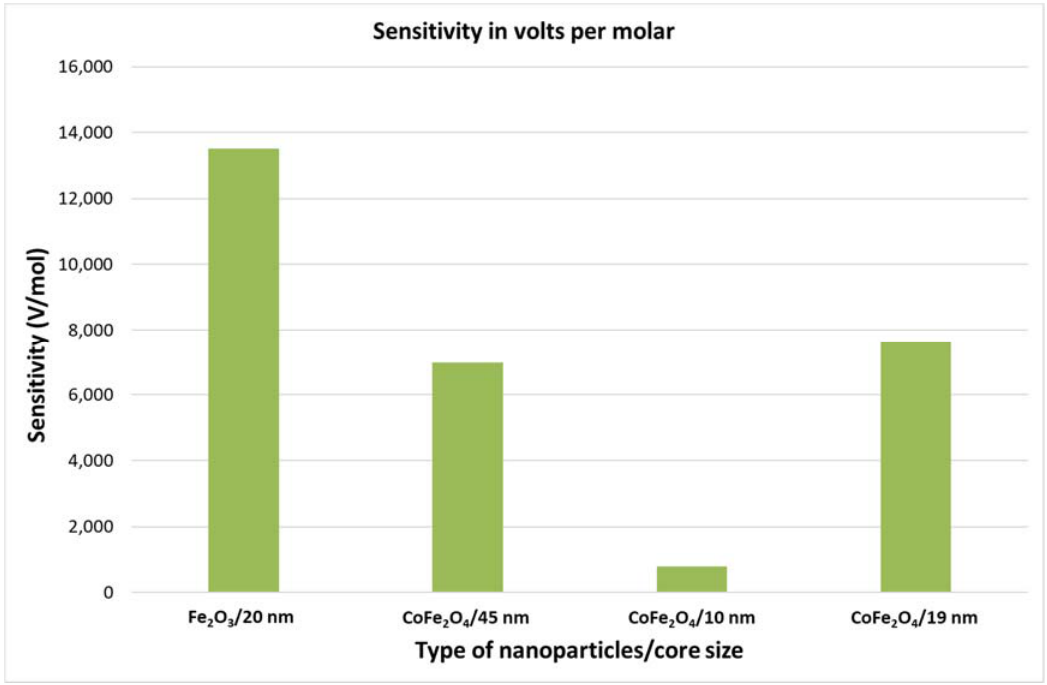
Figure 8. Sensitivity of the magnetic detection per molar quantity of the different nanoparticles. Details on the type of particles are provided in the Supplementary Materials.